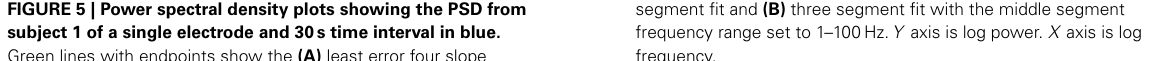
segment fit and (B) three segment fit with the middle segment frequency range set to 1–100Hz. Y axis is log power. X axis is log